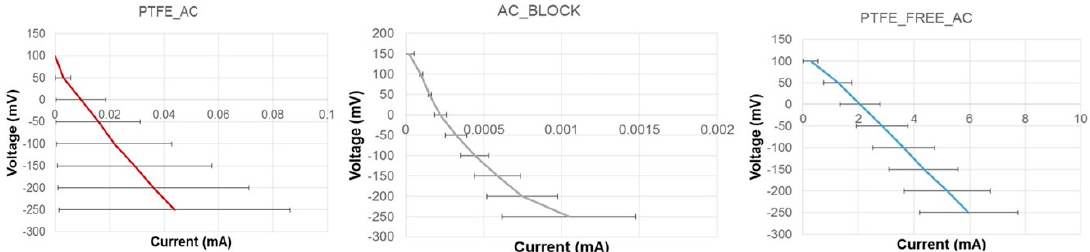
Figure 4. Linear sweep voltammetry results of the three cathode electrodes (250 mV/S) (n = 3).